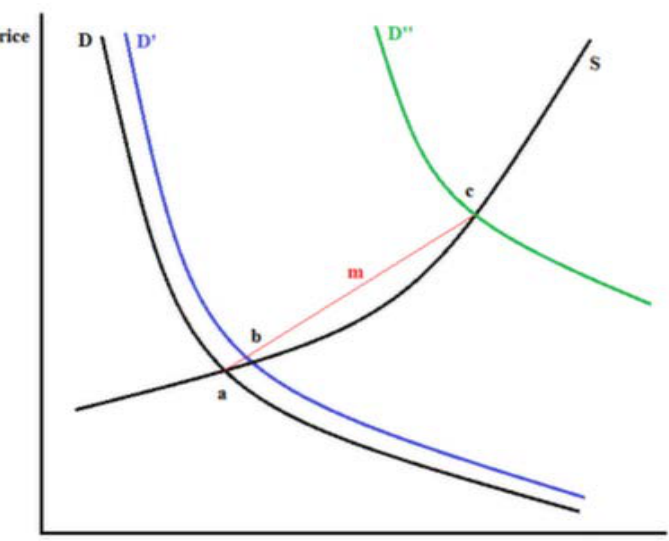
Figure 1 : When is Linearity a Reasonable